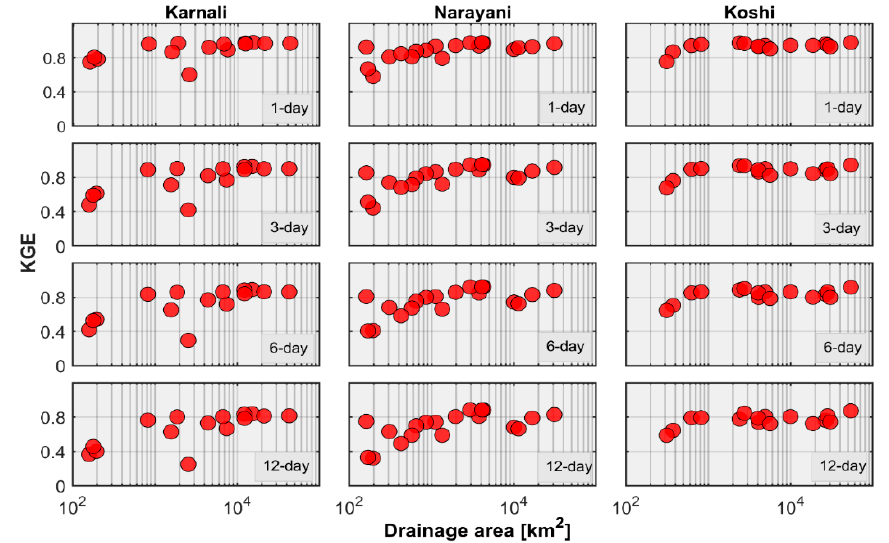
Figure 2. Relationship between the Kling–Gupta Efficiency (KGE) and drainage area across three major basins in Nepal. The columns show the Karnali, Narayani and Koshi river basins while the rows show lead times of 1, 3, 6 and 12 days, respectively.